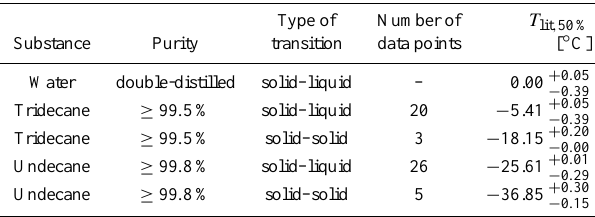
Table A1. Substances and their median phase transition tempera- tures derived from several sources which were used in the calibra- tion of the BINARY setup. The errors indicate the 25th and 75th percentiles.